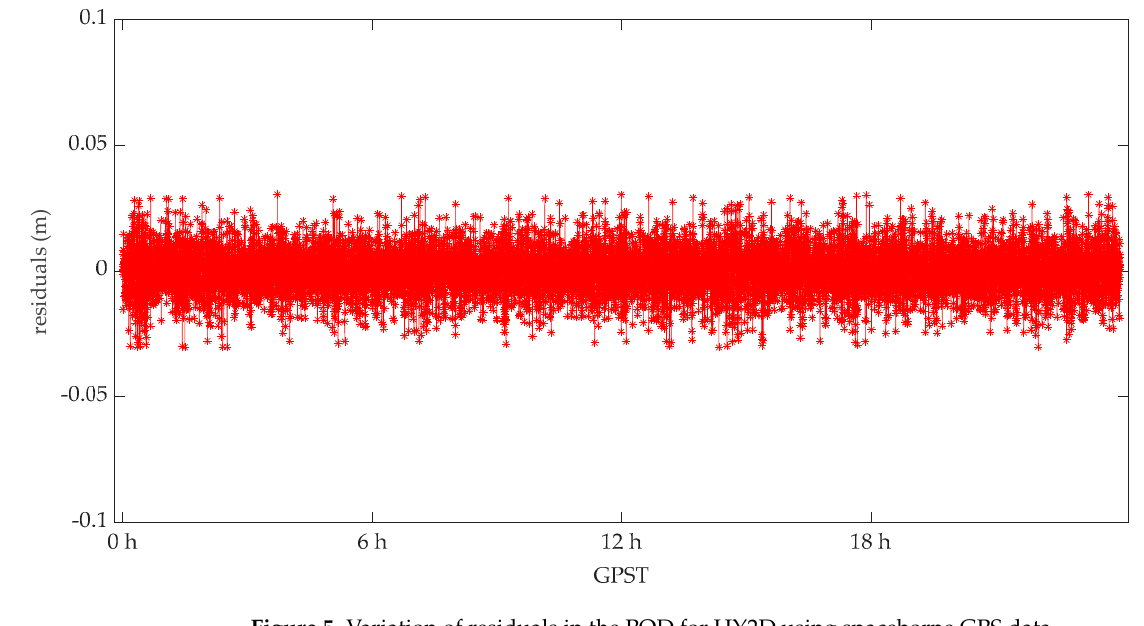
Figure 5. Variation of residuals in the POD for HY2D using spaceborne GPS data.